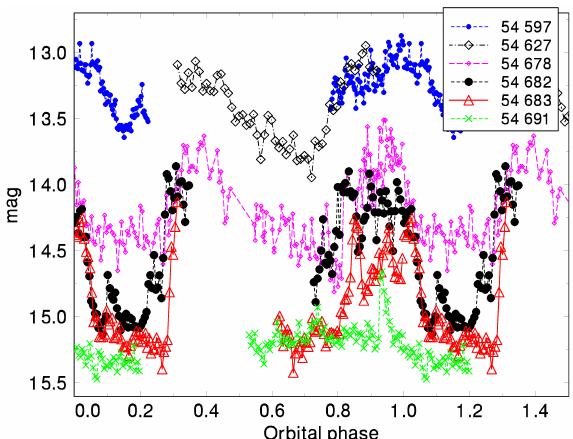
Figure 4: Dramatic changes of the orbital modula- tion during transition from the high to the low state of AM Her (CCD V -band AAVSO data). Time in JD– 2 400 000 is given in the legend. The orbital ephemeris of [5] is